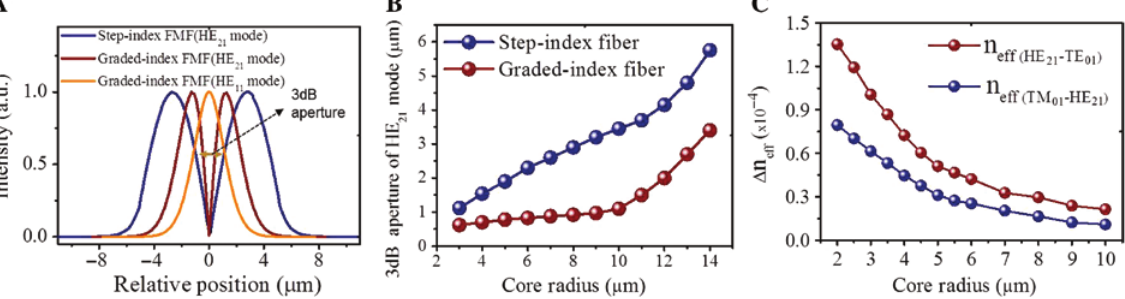
Figure 9: Comparison of step-index and graded-index fibers. (A) Intensity profiles of HE and HE modes in a step-index and graded-index few-mode fiber (FMF) based on numerical calculation. (B) The 21 11 3-dB aperture of HE mode as a function of FMF core radius. (C) Δ n 21